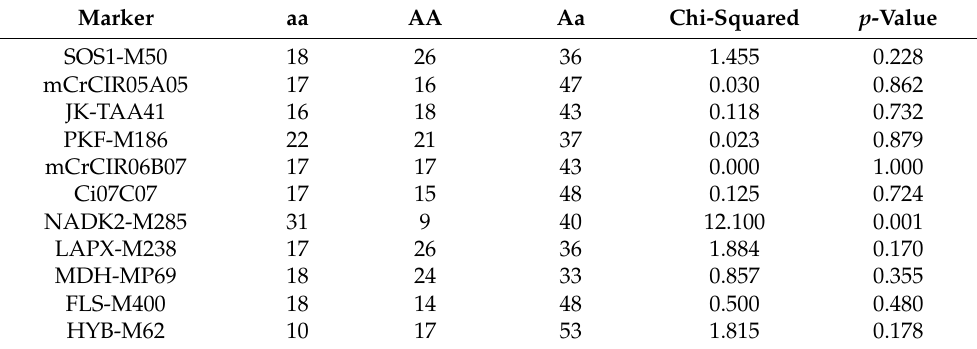
Table 2. Analysis of Mendelian allelic segregation (Chi-squared test with Bonferroni correction for multiple testing) of the recovered plants from the self-pollinated buds of the ‘Fortune’ mandarin.